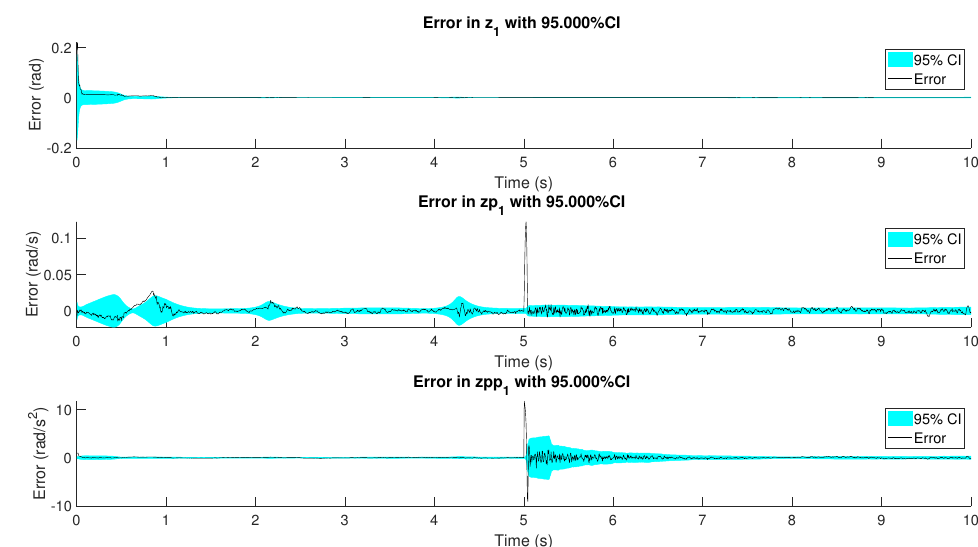
Figure 16. Error and confidence interval of the position, velocity and acceleration of the crank angle in the configuration which considers a gyroscope on the coupler.